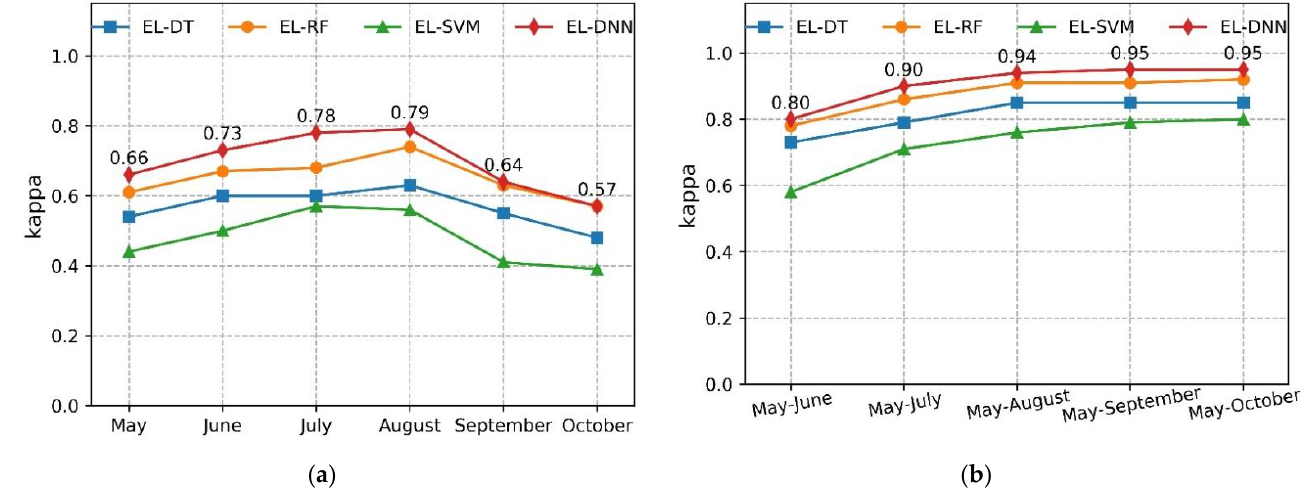
Figure 4. Kappa coefficient of different classification algorithms on the test data set (EL2021). ( a ) Single month kappa coefficient; ( b ) monthly time-series kappa coefficient.